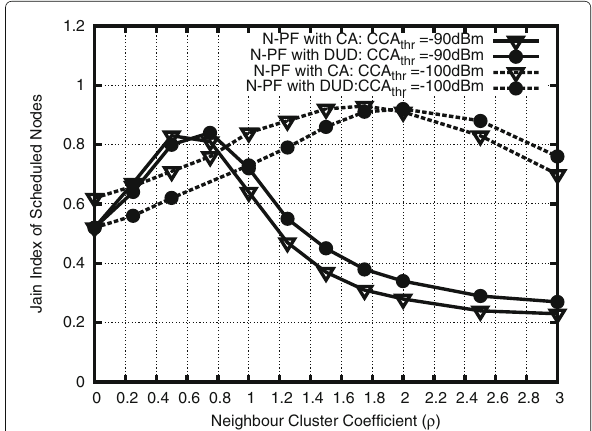
Fig. 13 Jain Index of the scheduled nodes with CA and DUD algorithms, for K = 100, M = 100, and different values of CCA